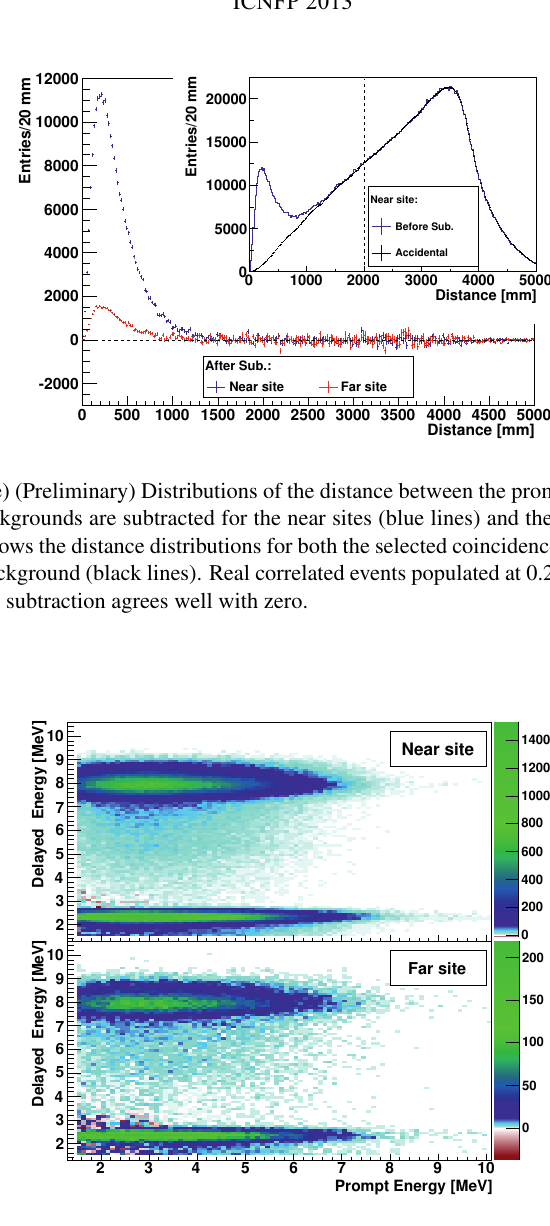
Figure 3. (Color online) (Preliminary) The prompt vs. delayed energy distribution after accidental background subtraction for the near (top) and far (bottom) sites. Clean nH and nGd signals can be